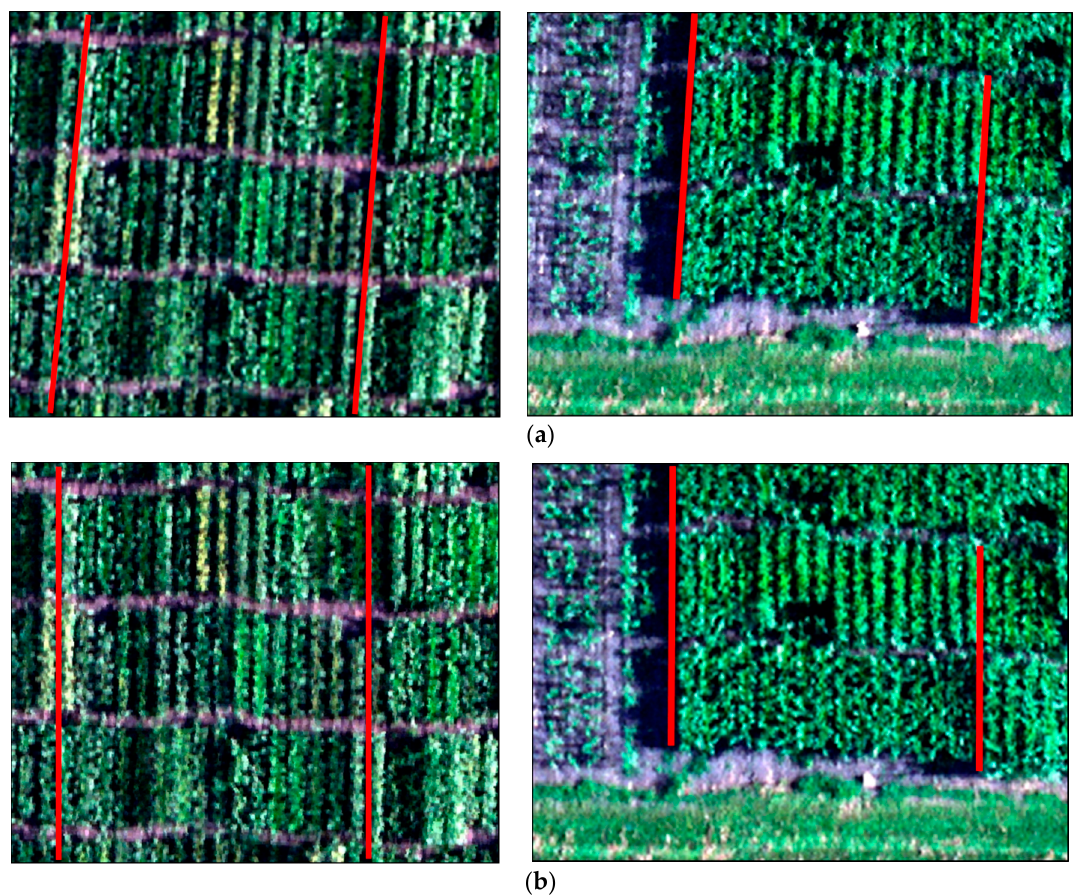
Figure 13. Subareas of the test field for visual inspection of the registration result: ( a ) partially-rectified hyperspectral orthophoto and ( b ) refined hyperspectral orthophoto generated by the proposed approach.